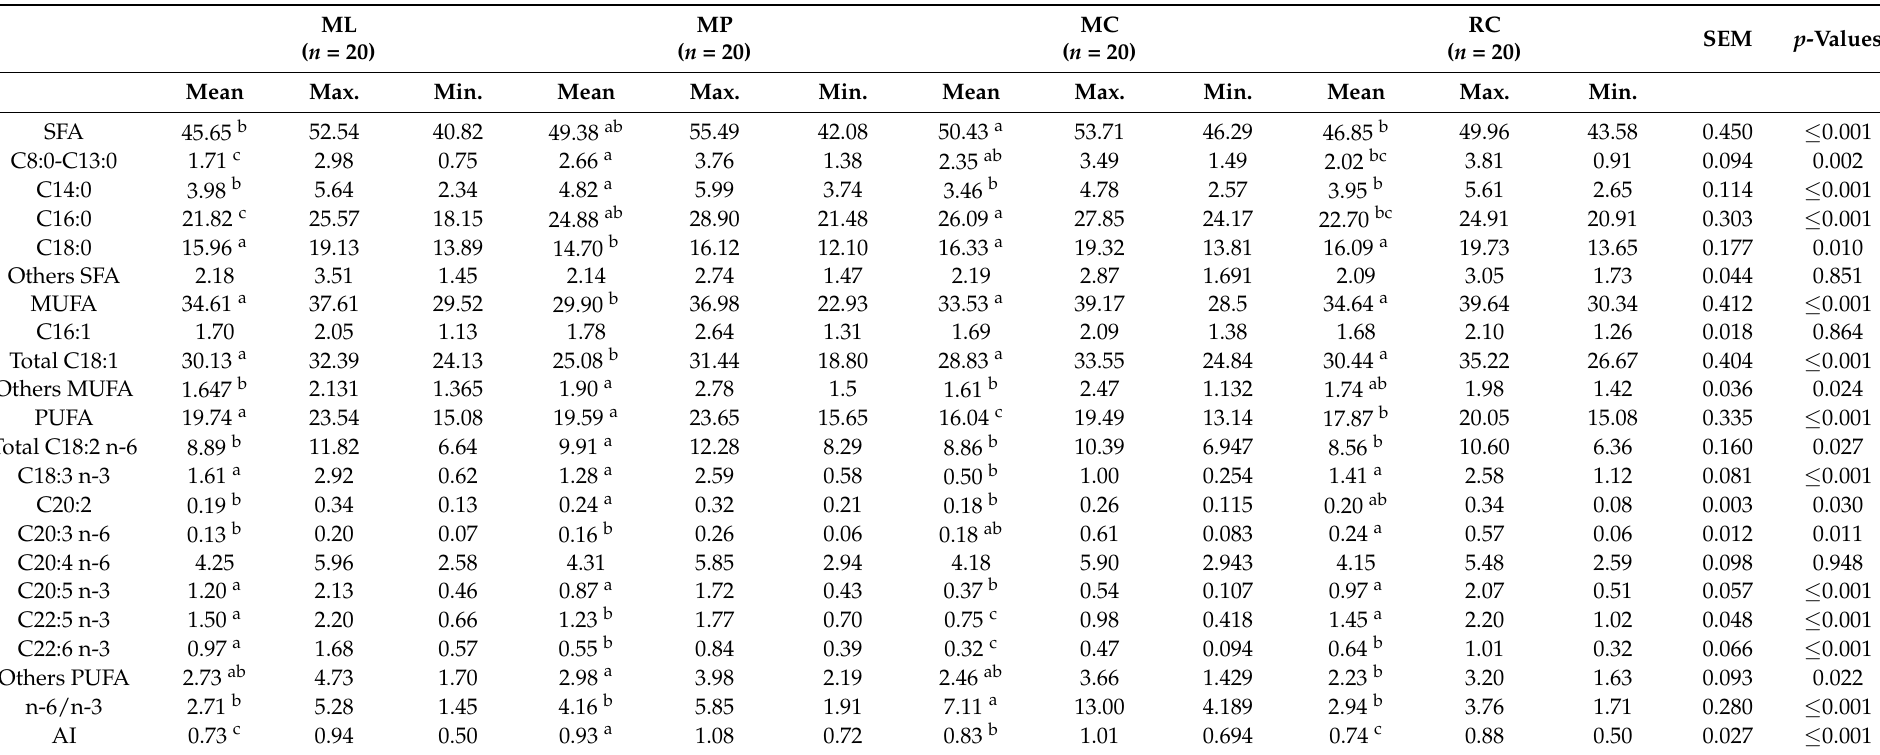
Table 3. Fatty acids identified (mean, maximum and minimum values expressed as % of the total fatty acid detected of intramuscular fat) from Mallorquina lambs suckling (ML), grazing (MP) and supplemented with grain (MC); and Roja Mallorquina lambs supplemented with grain